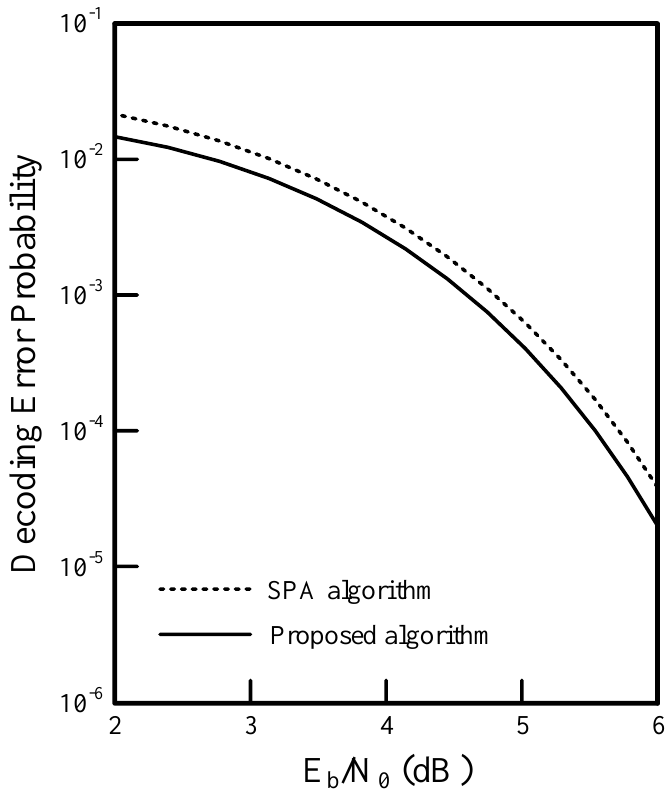
Figure 3. Error probability of Reed-Muller (64, 42).